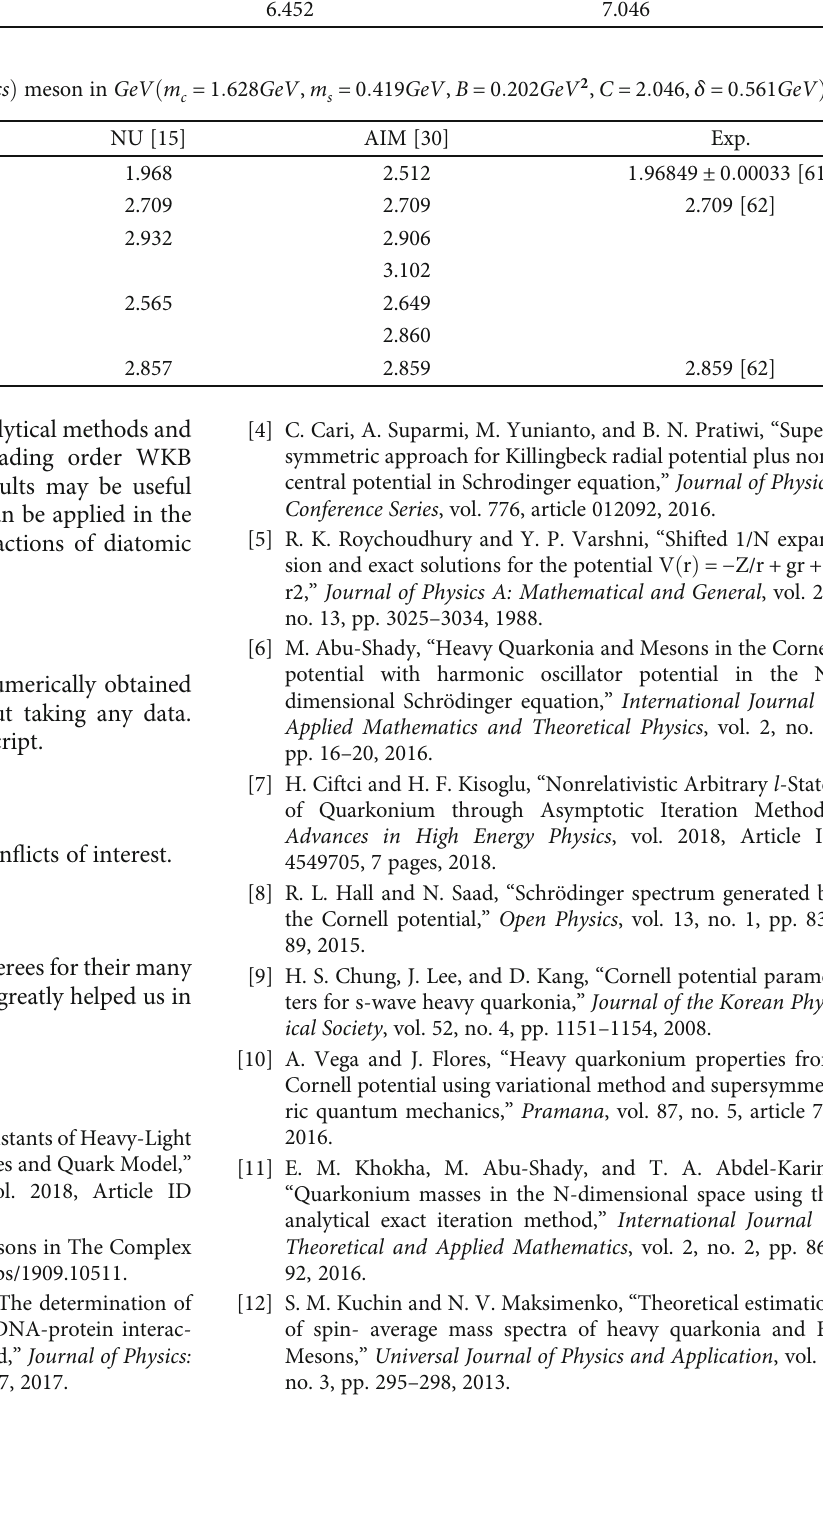
: 628 GeV , m : 419 GeV , B = 0 : 202 GeV 2 , C = 2 : 046, δ = 0 : 561 GeV Þ . c = 1 s = 0